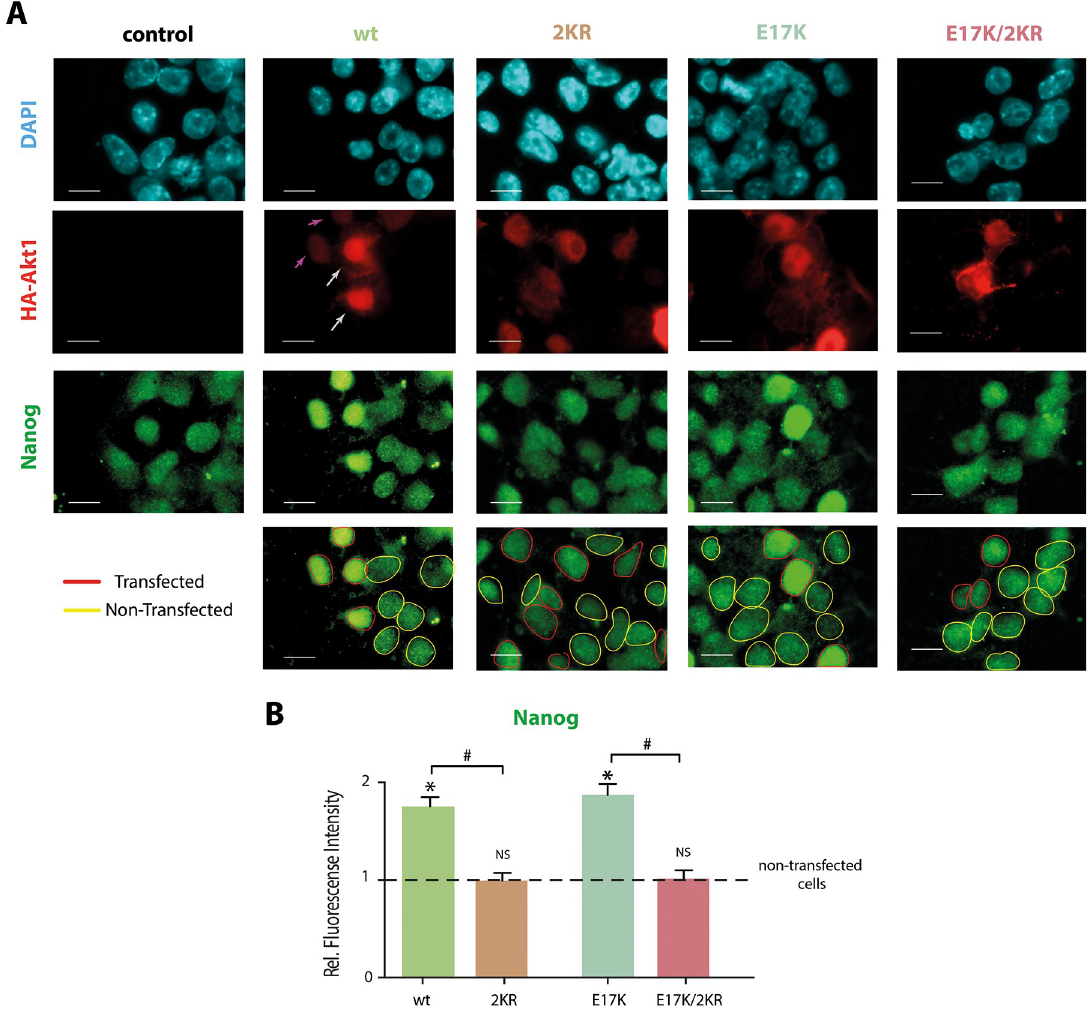
Fig 2. Nanog protein levels are increased by SUMOylatable Akt variants while mutants with diminished SUMOylatability have no